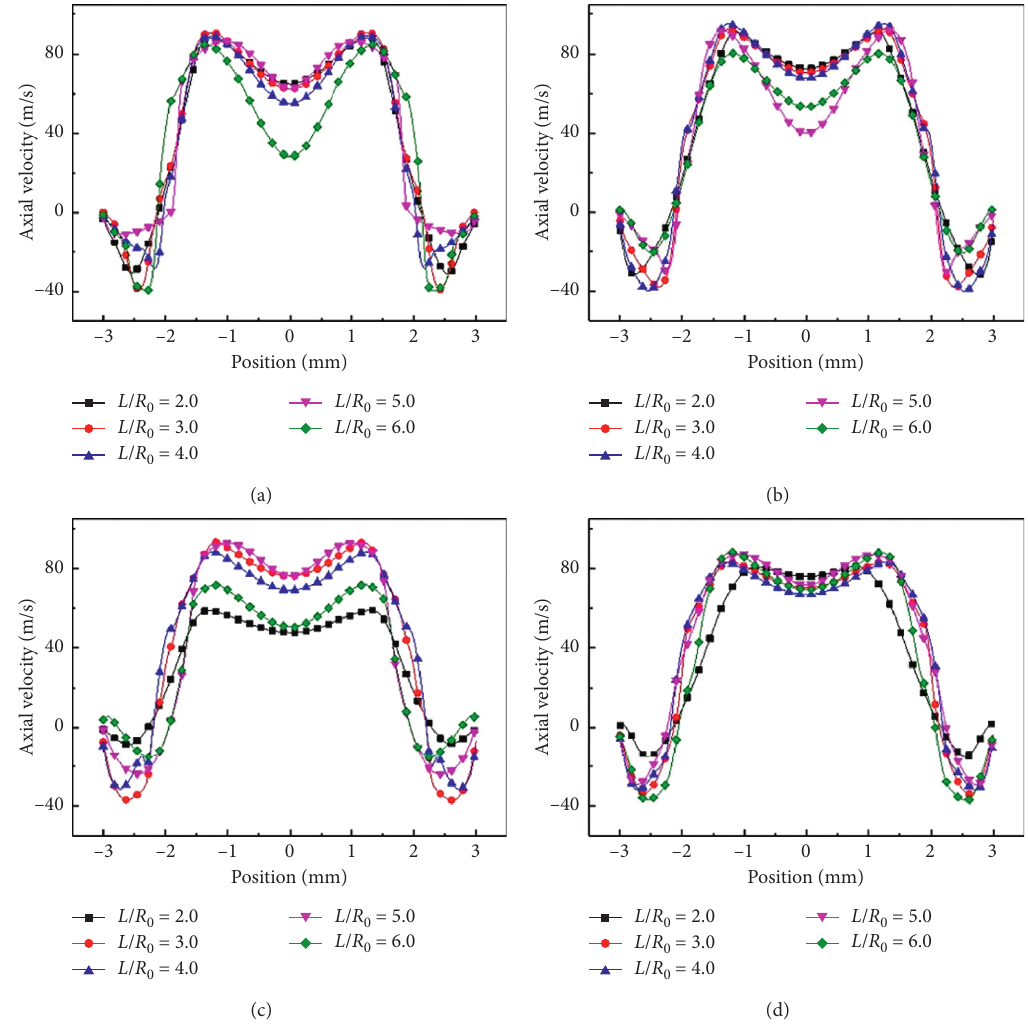
Figure 8: The distribution of the axial velocity downstream at x � 29mm, 32mm, 35mm, and 38 mm at the moment of 3 T /4. (a) x �